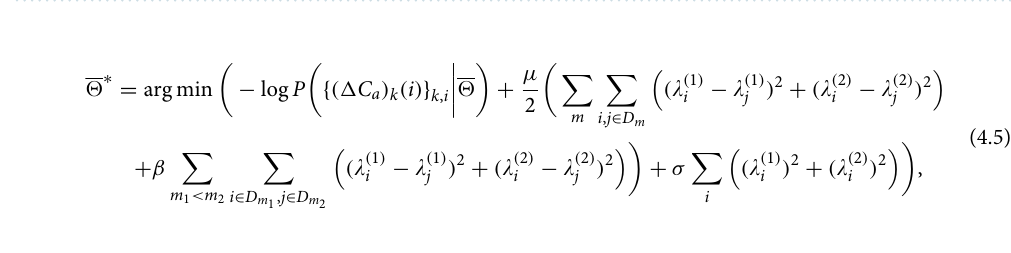
Table 9. Estimated transmission rates in Italy. θ ∗ is inferred using (4.5) with µ = 10 5.5 , at which the validation errors are minimized as shown in Fig. 17 and Supplementary Fig. S6. The posterior distribution is estimated by 5 × 10 5 MCMC iterations.